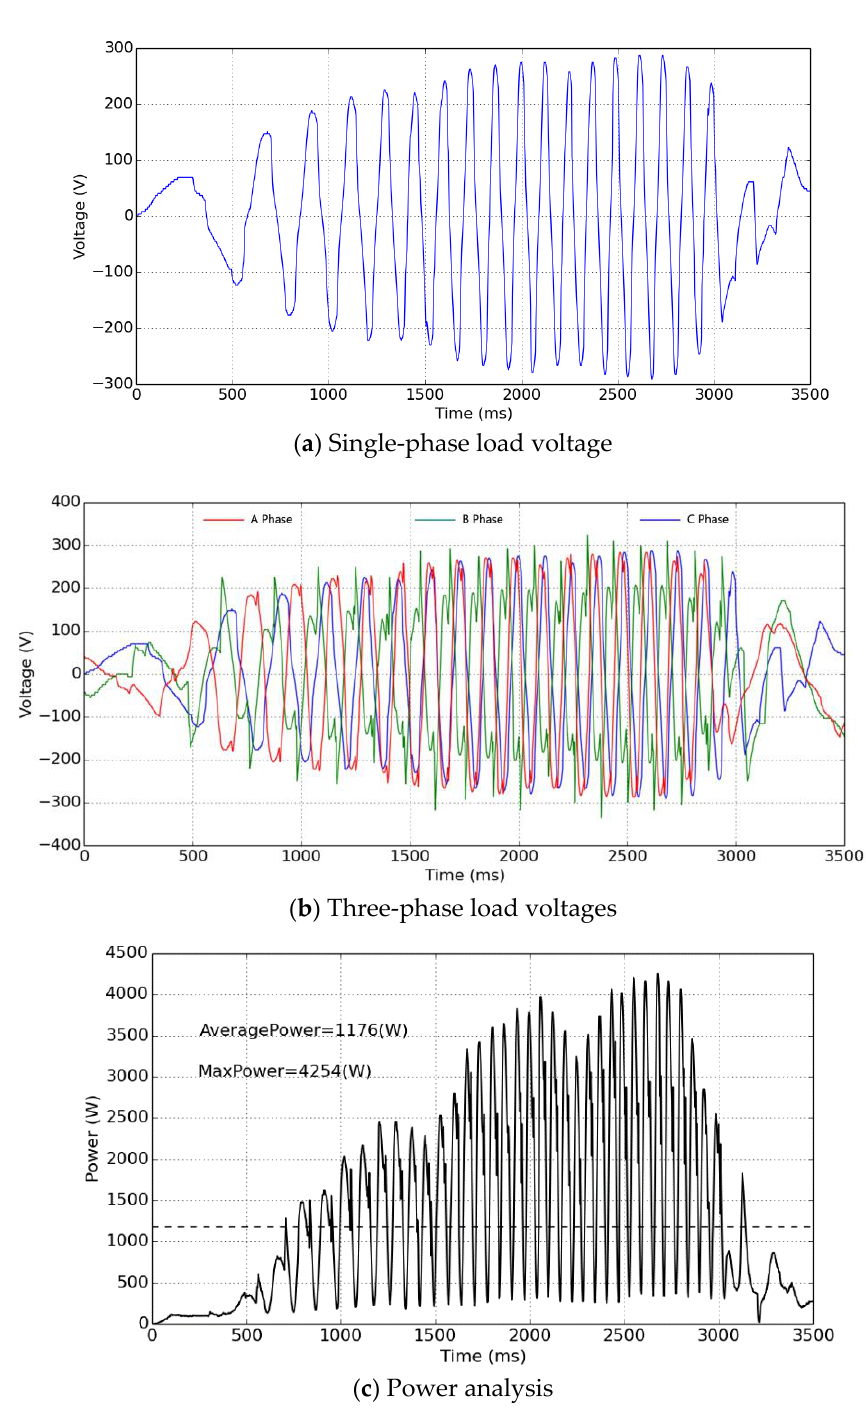
Figure 8a,b show the output load voltages of the double-buoy OWECS collected by the measuring device. Figure 8c is a power analysis of Figure 8a,b, in which the average power is 1.176 kW, and the maximum power is 4.254 kW.